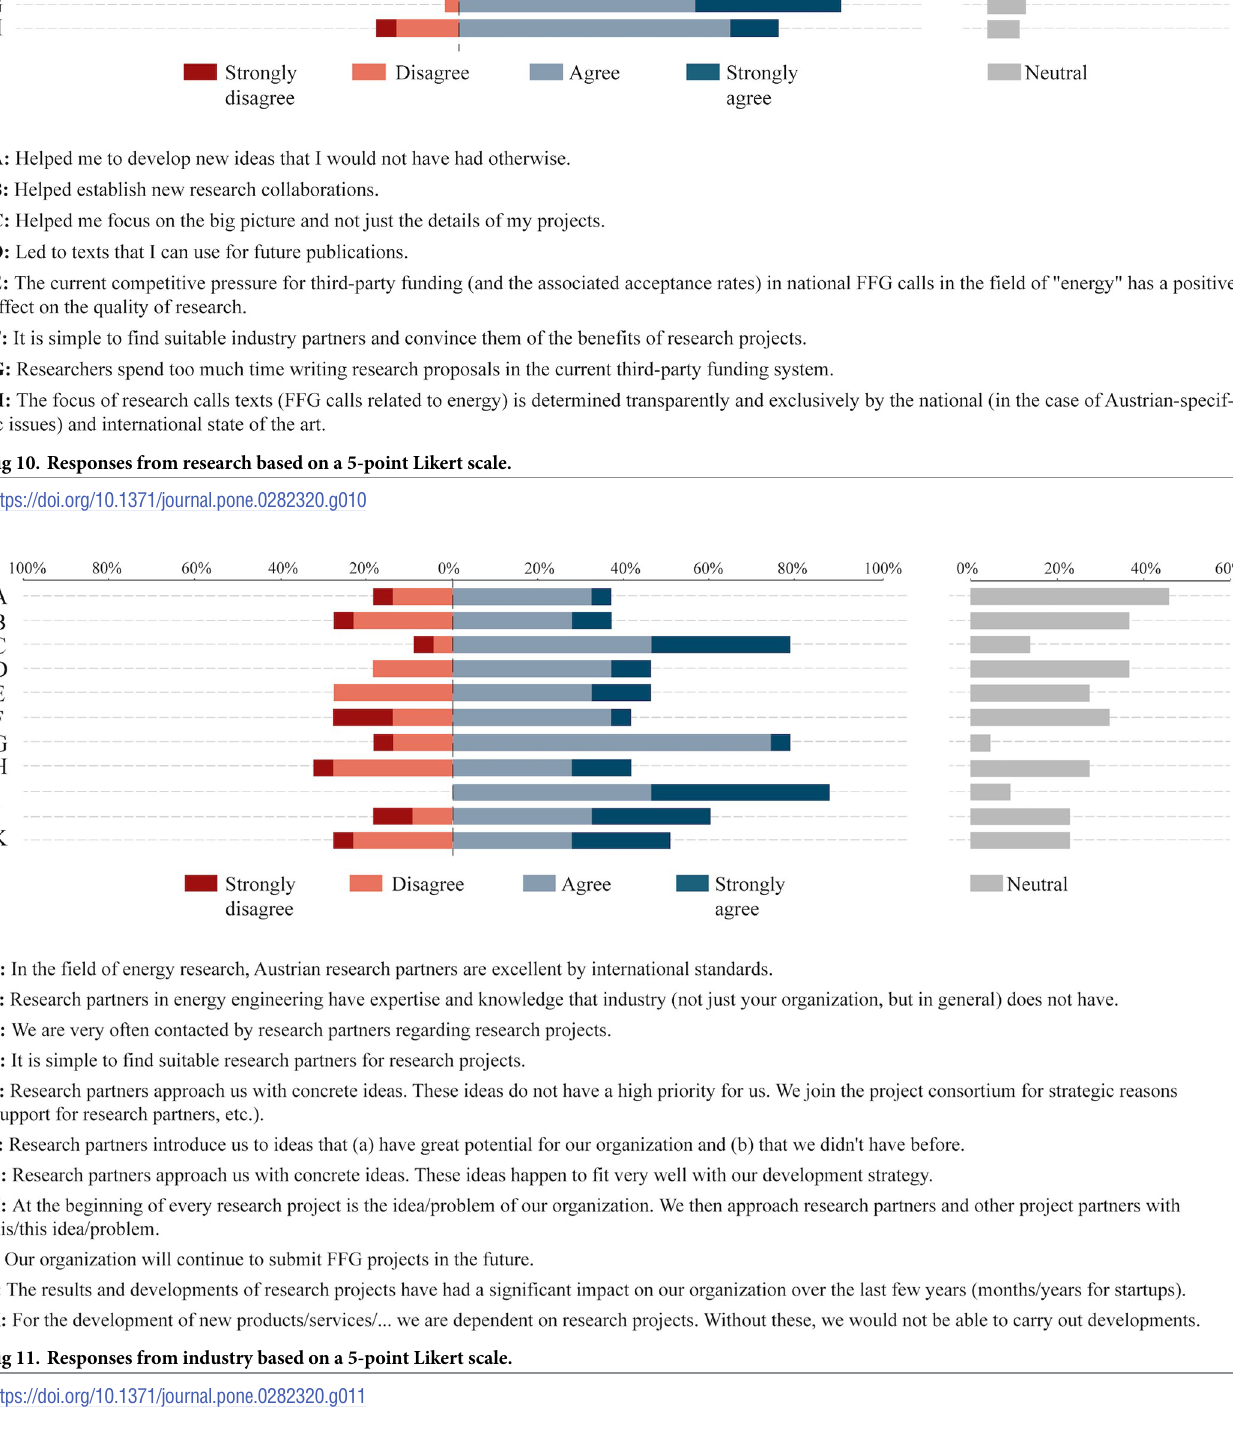
PLOS ONE | https://doi.org/10.1371/journal.pone.0282320 April 19,